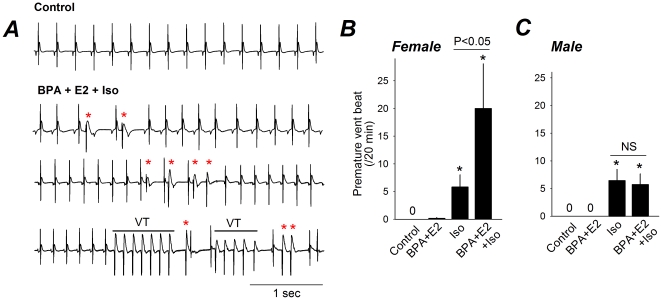
Acute exposures to BPA and E2 promote ventricular arrhythmias in female rat hearts.(A) Representative surface ECG traces from female hearts under control or in the presence of BPA and E2, both at 10−9 M, and 10−8 M isoproterenol. Asterisks indicate premature ventricular beats (PVBs). VT: ventricular tachycardia. (B) Average frequency of PVBs in female hearts under various conditions. N = 6–11 hearts. (C) Average frequency of PVBs in male hearts under various conditions. N = 7–9 hearts. Error bars are SEM. *: P<0.05 vs. control in a t-test. NS (not significant): P>0.1.